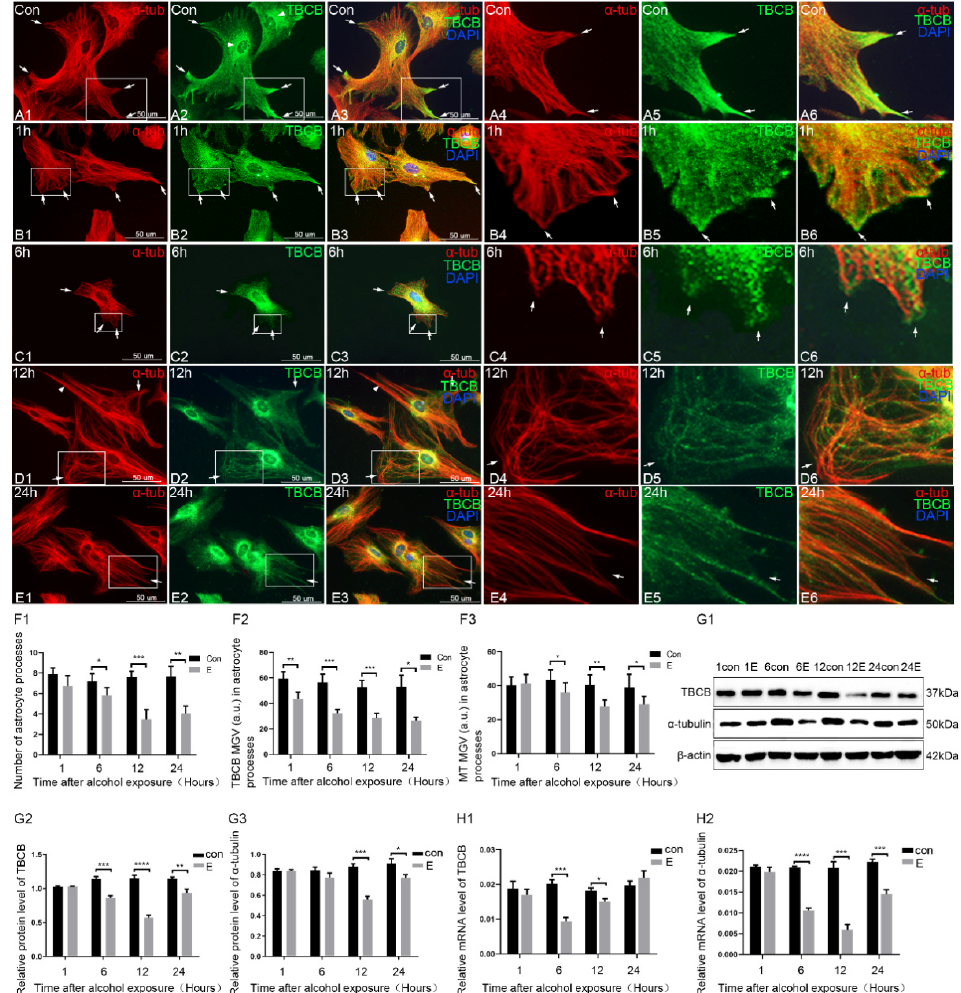
Figure 1. Disorder of astrocyte formation and decreased expression of TBCB after 1, 6, 12, and 24 h of acute foetal alcohol exposure. ( A – E ) Immunofluorescence showing changes in the expression of α -tubulin (red signal) and TBCB (green signal) in astrocytes after 1, 6, 12, and 24 h of acute foetal alcohol exposure. Panels A-E 4-6 are magnified images from the square area of Panels A-E 1-3. ( F ) The number of astrocyte processes and mean grey value (MGV) of TBCB and MT in astrocyte pro- cesses (MGV = integrated density/area) after 1, 6, 12, and 24 h of acute foetal alcohol exposure. ( G ) Western blot and ( H ) RT–PCR analysis of the protein and mRNA levels of TBCB and α -tubulin after 1, 6, 12, and 24 h of acute foetal alcohol exposure ( n = 6, p < 0.05). *: p < 0.05, **: p < 0.01, ***: p < 0.001, ****: p < 0.0001. The above results made it clear that alcohol could impede the formation of astrocyte processes and TBCB expression in these processes. It also suggested that there should be some links between the impaired formation of nascent astrocyte processes and the loss of TBCB expression. To verify this speculation, we used siRNA to silence TBCB expression in astrocytes. 3.2. Silencing TBCB Led to Inhibition of Astrocyte Process Formation To clarify the relationship between the reduction in TBCB and the inhibition of astro- cyte process formation, we performed TBCB silencing experiments with siRNA. In this experiment, the transfection efficiency of TBCB siRNA was higher than 80% and the pos- itive astrocytes showed green fluorescence (Figure 2A,B1–B3). In the silencing group, the mRNA and protein expression of TBCB was significantly downregulated, as shown by